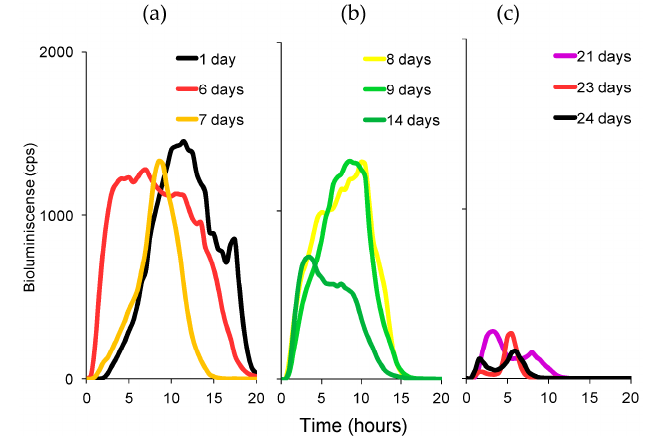
Figure 3. Representative bioluminescent emission profiles recorded from P. putida TVA8 bioreporter cells encapsulated in silica hydrogel on the optical fiber after consecutive daily exposures to toluene at 5.3 mg/L over a total of 24 days (fiber 1) (cps; counts/s). ( a ) days 1–7; ( b ) days 8–14; ( c ) days 15–24.